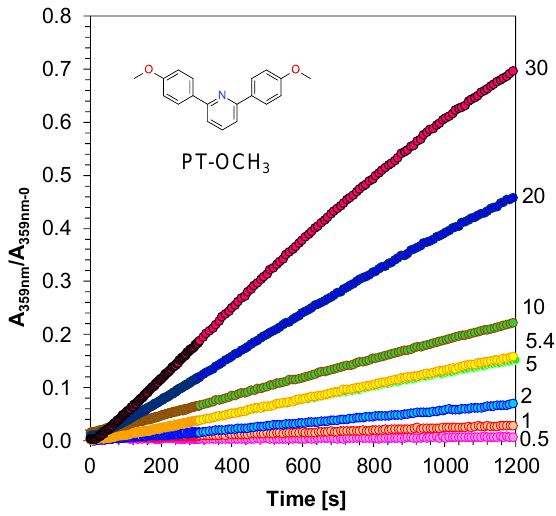
Figure 18. Profiles illustrating changes in absorbance over time of PT-OCH 3 at 320 nm (1 mW / cm 2 ) upon adding various amounts of HIP photoinitiator using the A 359nm / A 359nm-0 parameter.